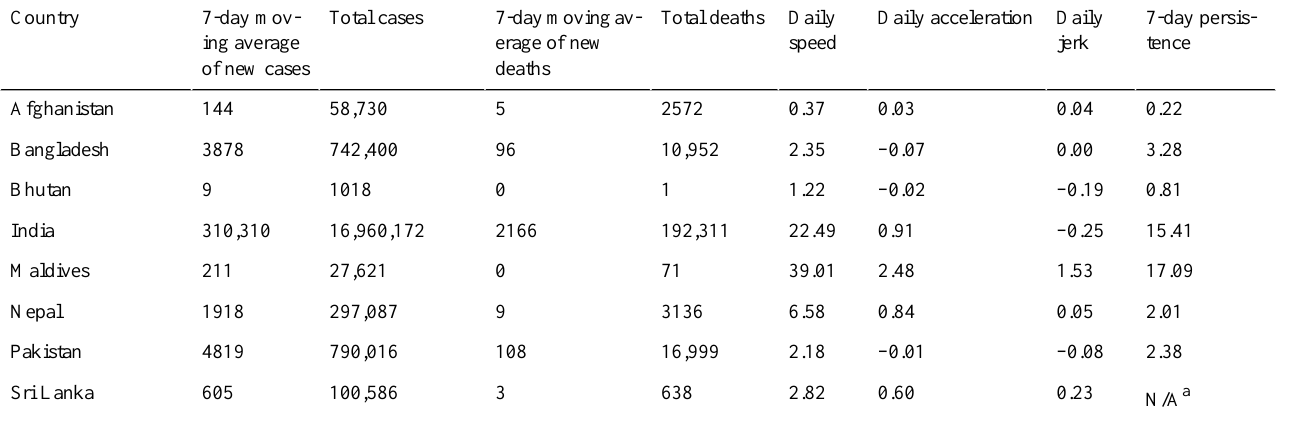
Table 3. Surveillance metrics for the week of April 19-25,